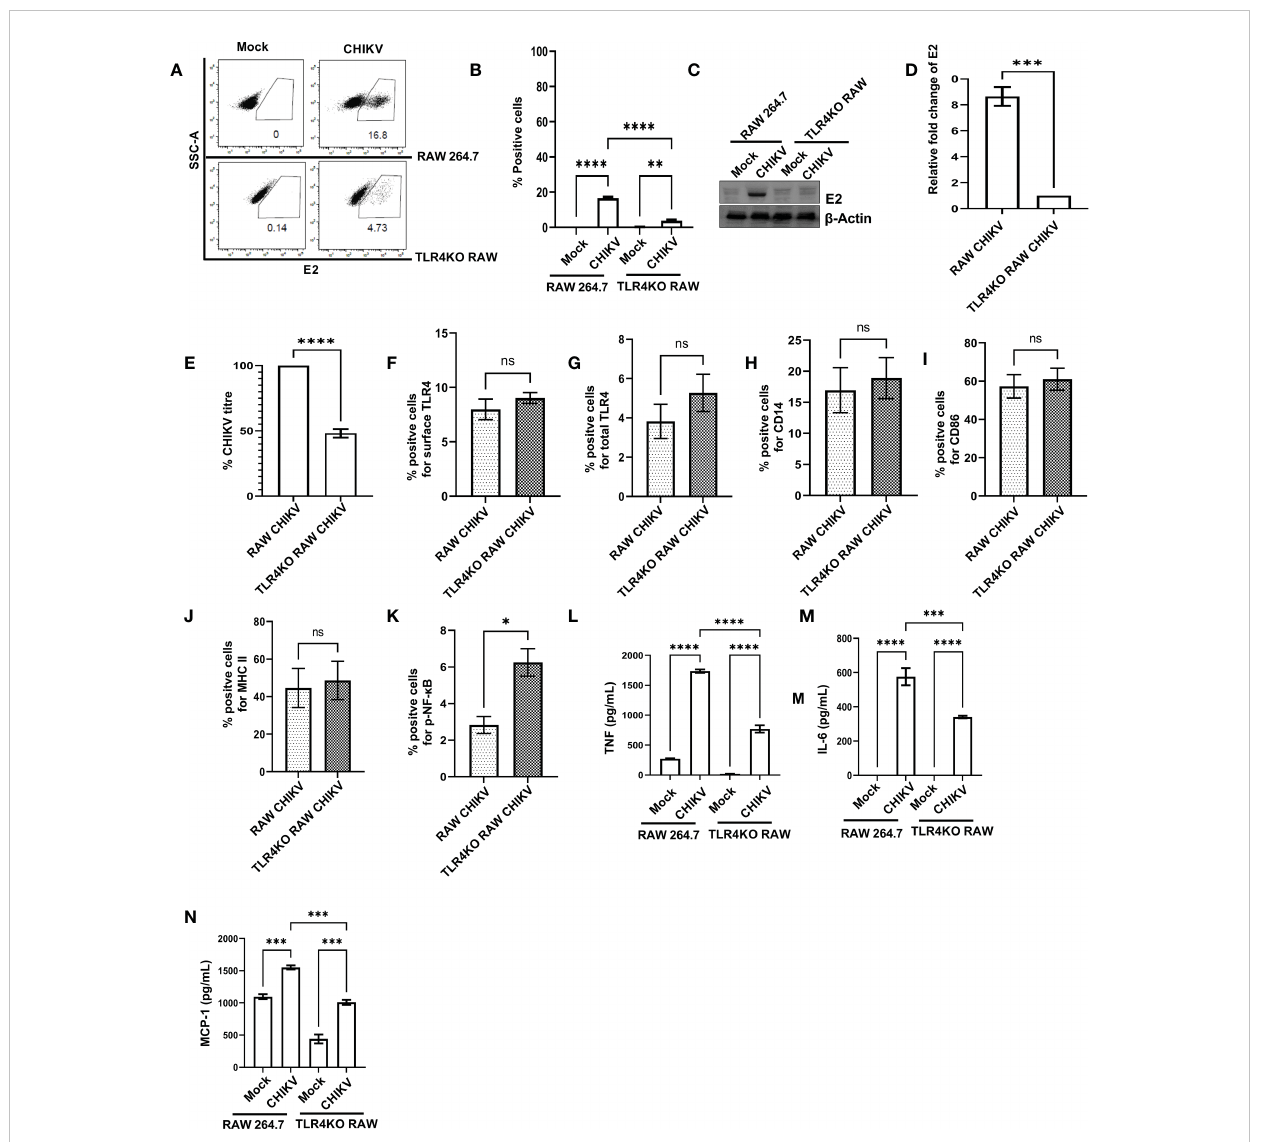
FIGURE 3 The presence of functional TLR4 facilitates CHIKV infection in host macrophages, in vitro. RAW264.7 and TLR4KO RAW cells were subjected to CHIKV infection at 5 MOI and harvested at 8 hpi (A, B) The fl ow cytometry dot plot analysis depicts comparative CHIKV-E2 expression. (C, D) Western blot analysis showing comparative E2 level. Normalization of E2 expression was done using b -actin as a housekeeping gene. (E) The bar diagram showing comparative CHIKV titre obtained from plaque assay (F – K) The fl ow cytometry dot plot-based bar diagram analysis showing percent positive cells expressing surface TLR4, total TLR4, CD14, CD86, MHC-II and p- NF- k B respectively in mock and CHIKV infected TLR4KO RAW cells. (L – N) Bar diagrams depicting ELISA-based TNF- a , IL-6 and MCP-1 quanti fi cation respectively in RAW 264.7 and TLR4KO RAW cells. Data represent the Mean ± SEM of three independent experiments. p < 0.05 was considered as a statistically signi fi cant difference between the groups (ns: non-signi fi cant, * p <0.05; ** p ≤ 0.01; *** p ≤ 0.001; **** p ≤